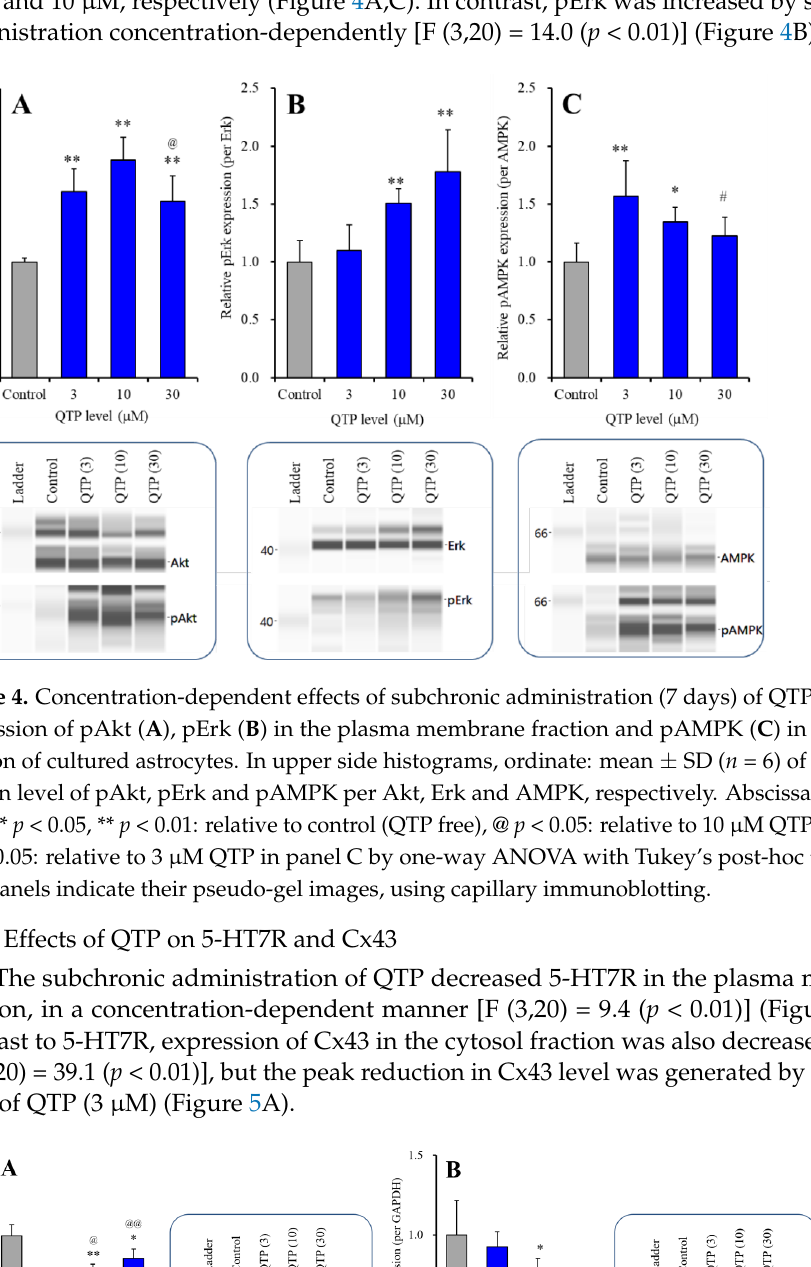
Figure 3. Interaction between subchronic administration of QTP and intracellular signalling inhibi- tors, 10 μM DEBC ( A ), 20 μM FR180204 ( B ) and 10 μM dorsomorphin ( C ) on astroglial ripple-burst evoked D-serine release. Ordinates indicate the mean ± SD of extracellular D- serine level (μM) ( n = 6). Abscissa indicates QTP concentration (μM). * p < 0.05, ** p < 0.01; relative to QTP free, @ p < 0.05,